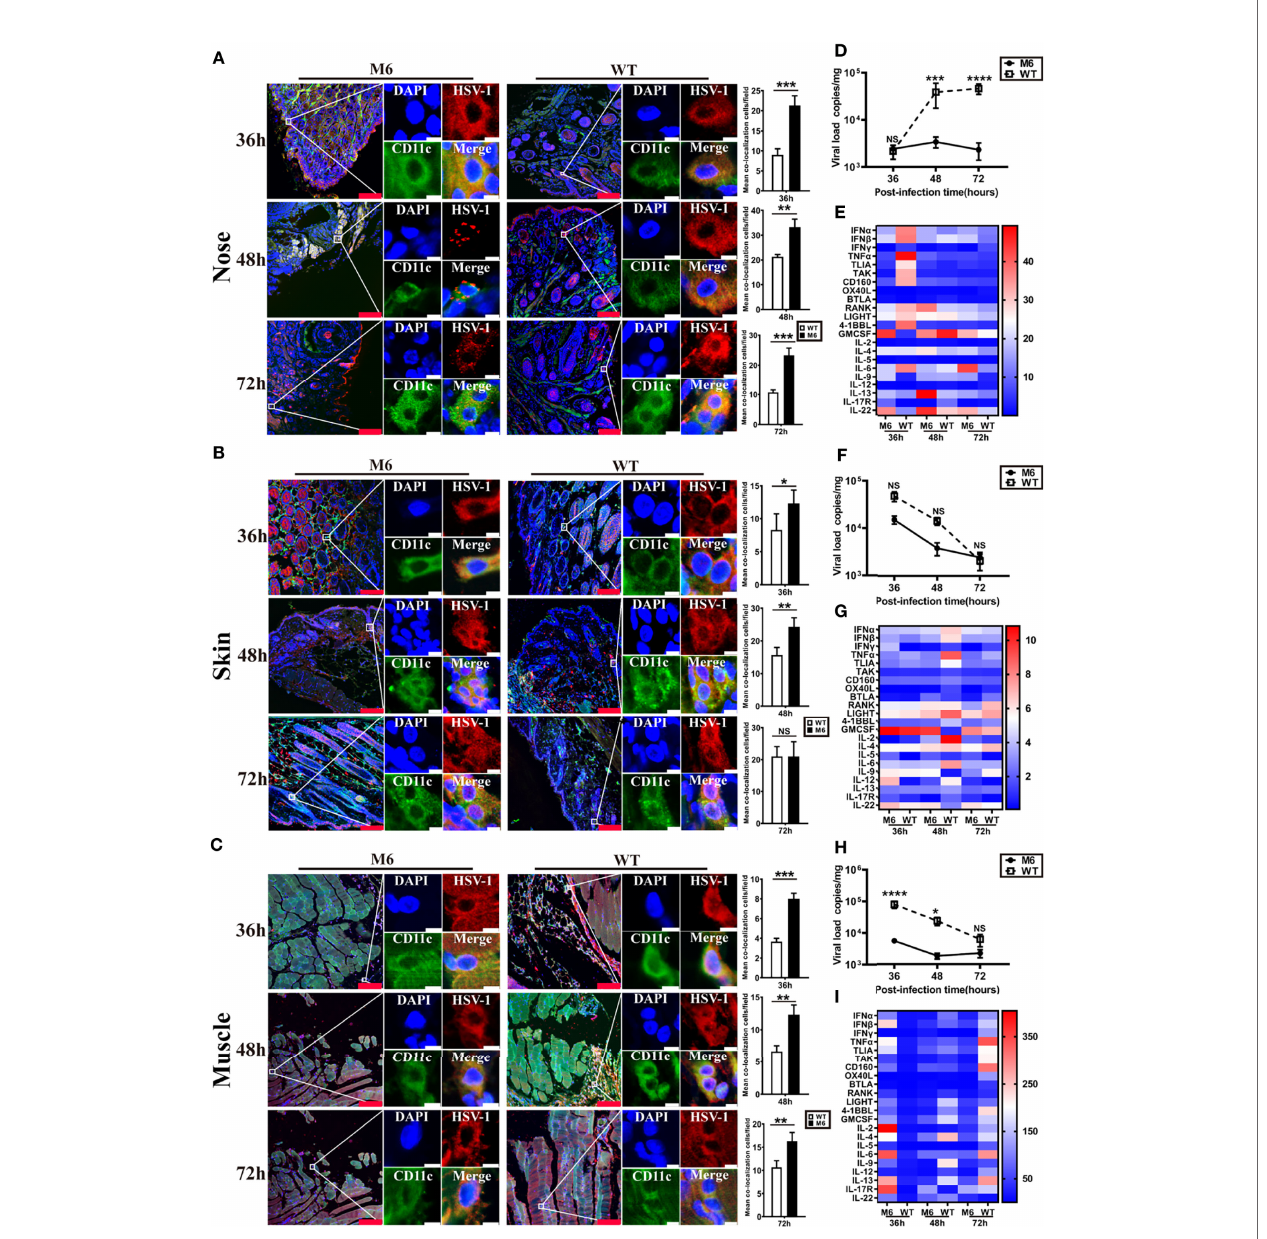
FIGURE 3 | The innate immune responses in local tissues after HSV-1 via different infection routes. Representative confocal fl uorescence images of HSV-1 expression (red) and CD11c (green) after intranasal (IN) (A) , intradermal (ID) (B) and intramuscular (IM) (C) administration of HSV-1 antigen at 36 h, 48 h and 72 hpi. The image on the right represents the colocalization rates of DC cells after intranasal (IN) (A) , intradermal (ID) (B) , and intramuscular (IM) (C) administration. White represents M6 infection, and black represents WT infection. Representative fl uorescent cells in the white rectangle are shown at 20× magni fi cation. The red scale bar is 100 µm, white scale bar is 5 µm. Statistical analysis of colocalization with both HSV-1 and DCs (marked by CD11c) compared to observations of 50 DCs randomly counted. Viral load in the nose (D) , skin (F) , and muscle (H) tissue of mice infected with M6 (circle) and WT (square) via different routes. Expression pro fi les of immune regulatory molecules in the nose (E) , skin (G) , and muscle (I) tissue of mice infected with M6 and WT. A heat map shows the dynamic gene expression pro fi les. Each column represents one dataset. The red color indicates the genes expressed at higher levels in the samples than those at 0 hpi, and the blue color indicates the genes expressed at lower levels. The darker the color, the more signi fi cant the change. The data are shown as the mean ± SEM based on data from three independent experiments. * P < 0.05, ** P < 0.01, *** P < 0.001, **** P < 0.0001. NS, no signi fi